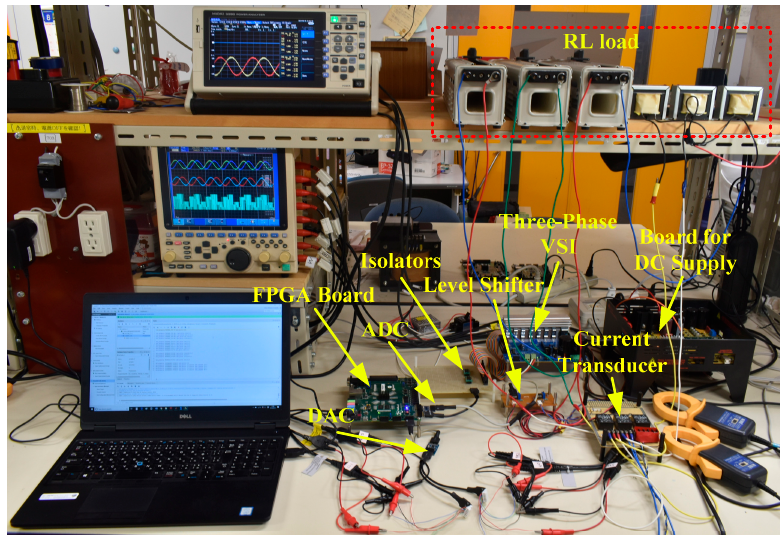
Figure 11. Laboratory prototype of the experimental setup. Table 3. Description of components specifications for the experimental system. S.